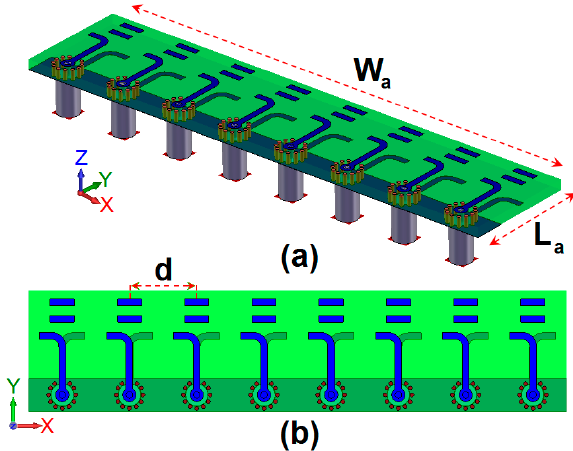
Figure 8. ( a ) 3D transparent and ( b ) top views of the linear phased array antenna.